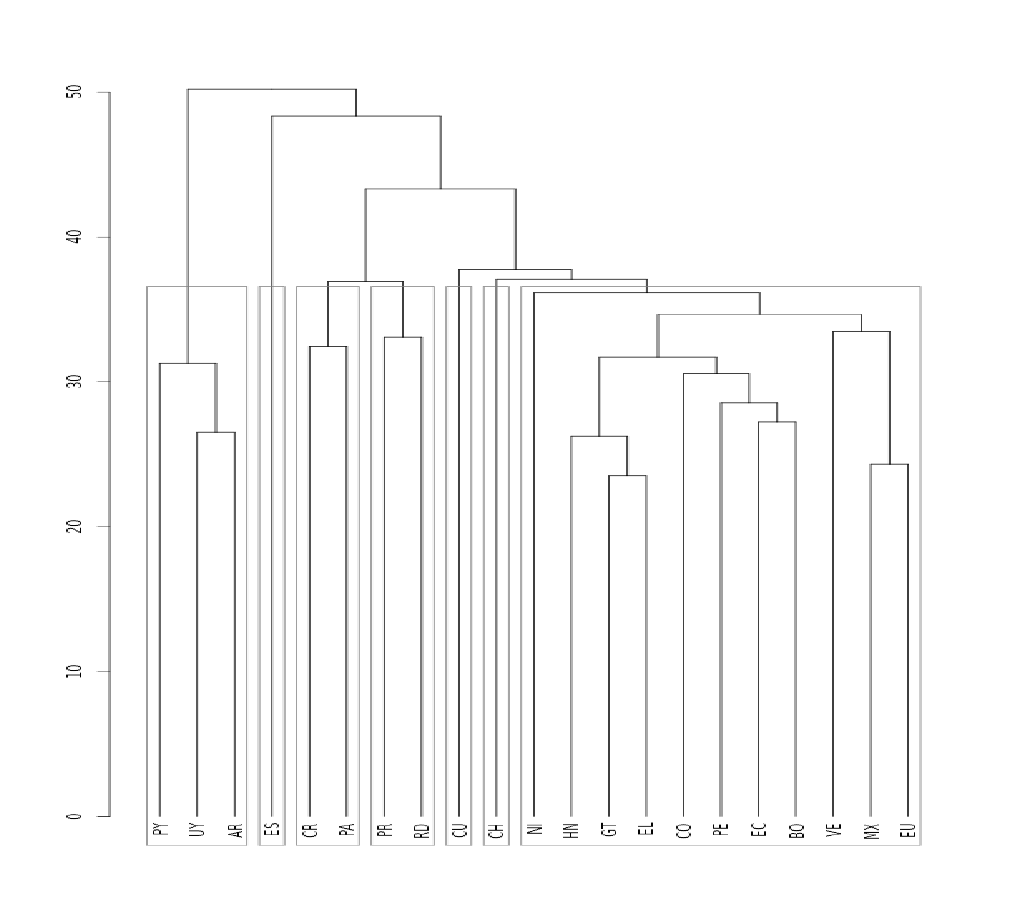
Figure 4. Hierarchical clustering dendogram using all 592 features